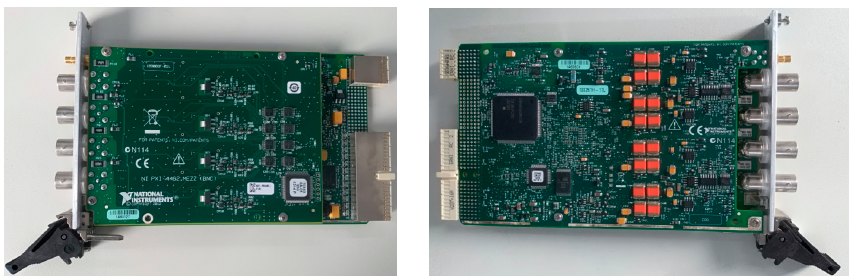
Figure 13. Hardware architecture of oscilloscopes.